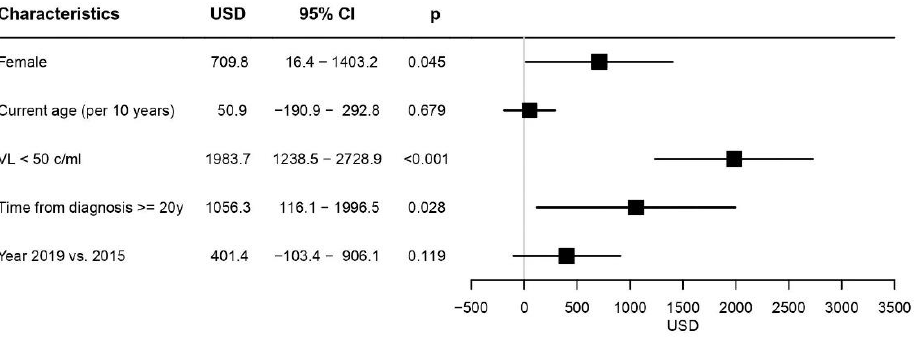
Figure 1. Forest plot demonstrating the factors associated with HIV-1-related direct costs as revealed by multivariable analysis. Mean additional costs, 95% CI and the significant levels associated with the cost for each factor are presented. The black boxes present the mean additional costs; the horizontal black lines present the 95% CI; the vertical grey line presents no change in costs.